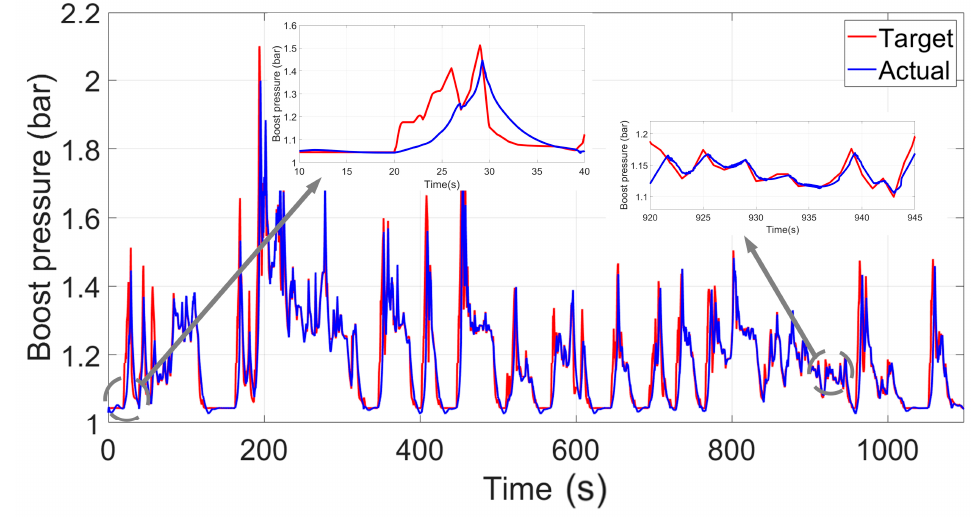
Figure 11. Control behavior of the proposed hybrid algorithm.